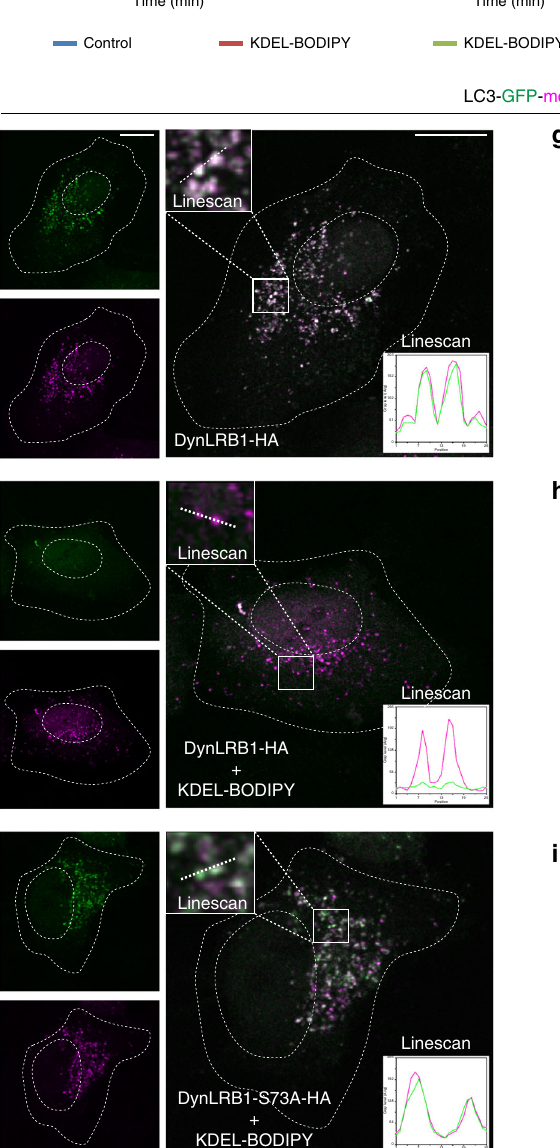
LinescanLinescanLinescan